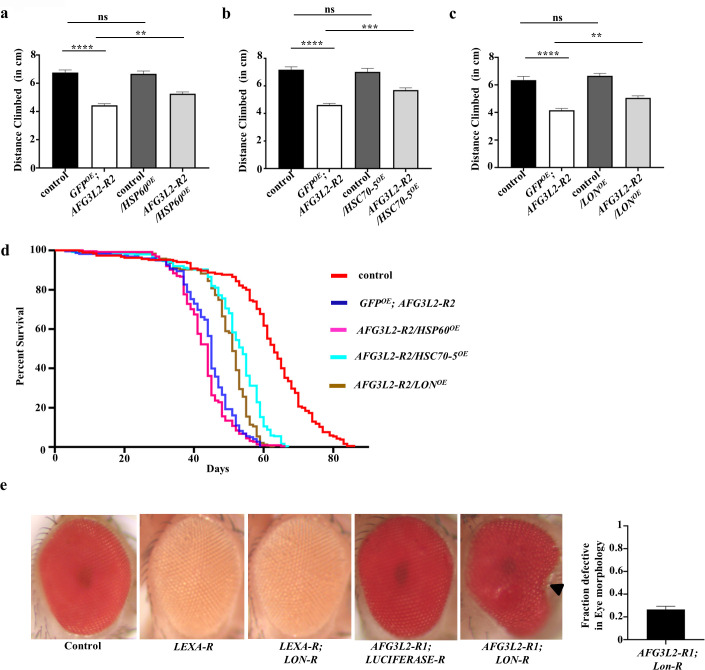
Overexpression of mito-UPR components partially rescues the locomotion and lifespan defects of AFG3L2-deficient animals.a. Climbing performance of 1-day old adult controls (elav-Gal4/UAS-GFP; UAS-LUCIFERASE RNAi; N = 101), AFG3L2-deficient animals: GFPOE; AFG3L2-R2 (elav-Gal4/UAS-GFP; UAS-AFG3L2-R2 RNAi; N = 94), control flies overexpressing Hsp60: control/HSP60OE (elav-Gal4; UAS-LUCIFERASE RNAi/UAS-HSP60; N = 92) and AFG3L2-deficient animals overexpressing Hsp60: AFG3L2-R2/HSP60OE (elav-Gal4; UAS-AFG3L2-R2 RNAi/UAS-HSP60; N = 100) (**p < 0.005, ****p < 0.0001 by one way ANOVA Tukey's test for multiple comparison). b. Climbing performance of 1-day old adult controls (elav-Gal4/UAS-GFP; UAS-LUCIFERASE RNAi; N = 63), AFG3L2-deficient animals: GFPOE; AFG3L2-R2 (elav-Gal4/UAS-GFP; UAS-AFG3L2-R2 RNAi; N = 65), control flies overexpressing Hsc70-5: Control/HSC70-5OE (elav-Gal4; UAS-LUCIFERASE RNAi/UAS-HSC70-5; N = 48) and AFG3L2-deficient animals overexpressing Hsc70-5: AFG3L2-R2/HSC70-5OE (elav-Gal4; UAS-AFG3L2-R2 RNAi/UAS-HSC70-5; N = 66) (***p < 0.0005, ****p < 0.0001 by one way ANOVA Tukey's test for multiple comparison). c. Climbing performance of 1-day old adult controls (elav-Gal4/UAS-GFP; UAS-LUCIFERASE RNAi; N = 53),), AFG3L2-deficient animals: GFPOE; AFG3L2-R2 (elav-Gal4/UAS-GFP; UAS-AFG3L2-R2 RNAi; N = 64), control flies overexpressing Lon: control/LONOE (elav-Gal4/TRiP-OE LON; UAS-LUCIFERASE RNAi/UAS-dCAS9-FLAG-VPR; N = 74) and AFG3L2-deficient animals overexpressing Lon: AFG3L2-R2/LONOE (elav-Gal4/TRiP-OE LON; UAS-AFG3L2-R2 RNAi /UAS-dCAS9-FLAG-VPR; N = 86). (**p < 0.005, ****p < 0.0001 by one way ANOVA Tukey's test for multiple comparison). d. Kaplan–Meier survival curves of controls (elav-Gal4/UAS-GFP; UAS-LUCIFERASE RNAi; N = 185, 50% survival 67 days), AFG3L2-deficient animals: GFPOE; AFG3L2-R2 (elav-Gal4/UAS-GFP; UAS-AFG3L2-R2 RNAi; N = 218, 50% survival 45 days), AFG3L2-deficient animals overexpressing Hsp60: AFG3L2-R2/HSP60OE (elav-Gal4; UAS-AFG3L2-R2 RNAi/UAS-HSP60; N = 224, 50% survival 44 days), AFG3L2-deficient animals overexpressing Hsc70-5: AFG3L2-R2/HSC70-5OE (elav-Gal4; UAS-AFG3L2-R2 RNAi/UAS-HSC70-5; N = 237, 50% survival 52 days) and AFG3L2-deficient animals overexpressing Lon: AFG3L2-R2/LONOE (elav-Gal4/TRiP-OE LON; UAS-AFG3L2-R2 RNAi/UAS-dCAS9-FLAG-VPR; N = 239, 50% survival 51 days). Significance was determined using a Mantel-Cox log-rank test (****p < 0.0001). To account for the possible titration of Gal4 protein in the presence of two UAS transgenes and subsequent reduction in expression of the RNAi targeting AFG3L2, we included the UAS-GFP transgene along with the UAS-AFG3L2-R2 RNAi transgene in control animals in Figs. a-d. e. Eye morphology of controls (ey-Gal4; UAS-LUCIFERASE RNAi; N = 138), LEXA-RNAi expressing flies (ey-Gal4/UAS-LEXA RNAi; N = 108), Lon-deficient flies: LEXA-R; LON-R (ey-Gal4/UAS-LEXA RNAi; UAS-LON RNAi; N = 169), AFG3L2-deficient animals: AFG3L2-R1; LUCIFERASE-R (ey-Gal4/UAS-AFG3L2-R1 RNAi; UAS-LUCIFERASE RNAi; N = 231) and AFG3L2-deficient animals expressing an RNAi construct targeting Lon: AFG3L2-R1; LON-R (ey-Gal4/UAS-AFG3L2-R1 RNAi; UAS-LON RNAi; N = 241). To control for non-specific interactions, the control animals included RNAi lines targeting LexA and Luciferase, neither of which are encoded in the Drosophila genome. The right panel indicates the quantification of defective eye morphology in AFG3L2-R1; LON-R flies. None of the other genotypes tested had eye defects.